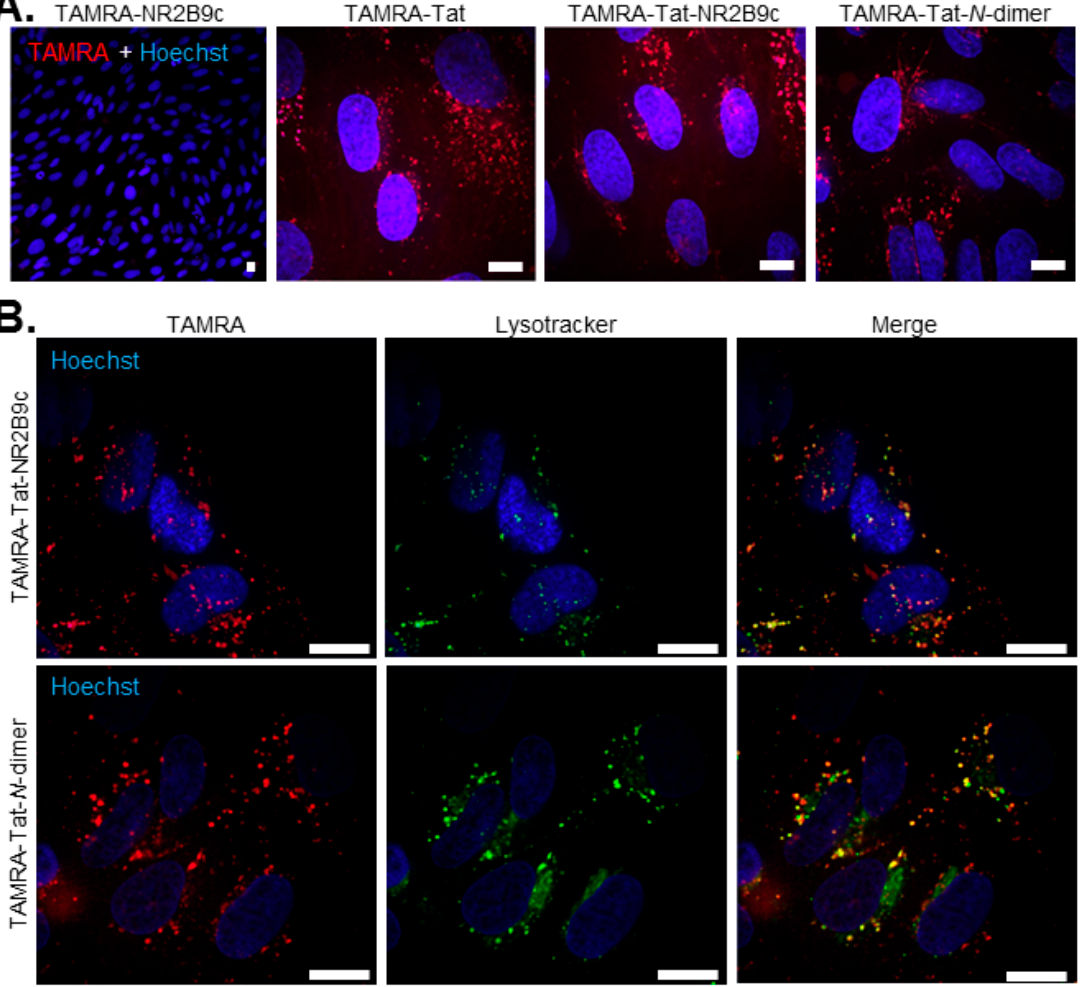
Figure 4. ( A ) Live cell imaging to visualize peptide uptake into bovine brain capillary endothelial